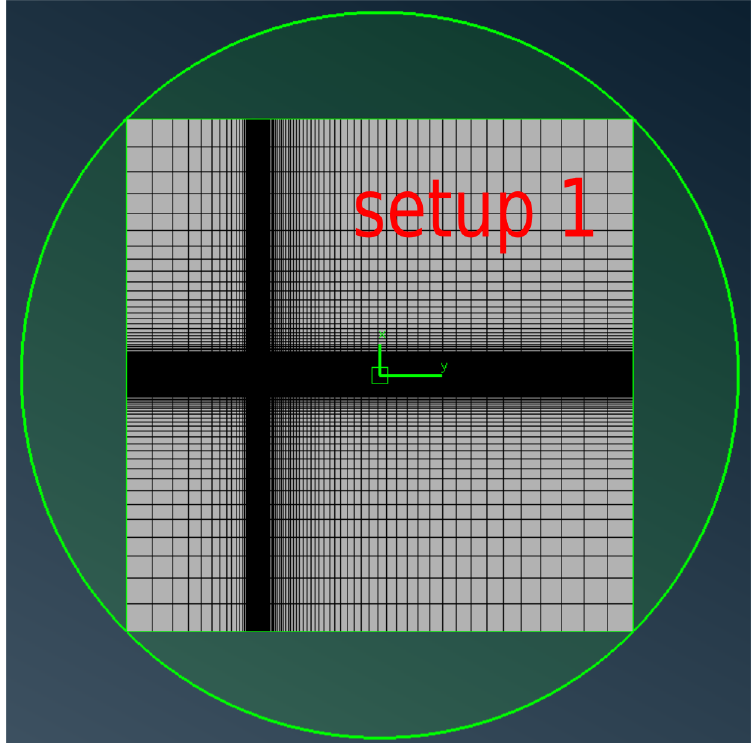
Figure 9. Wind turbine fully structured grid setup.